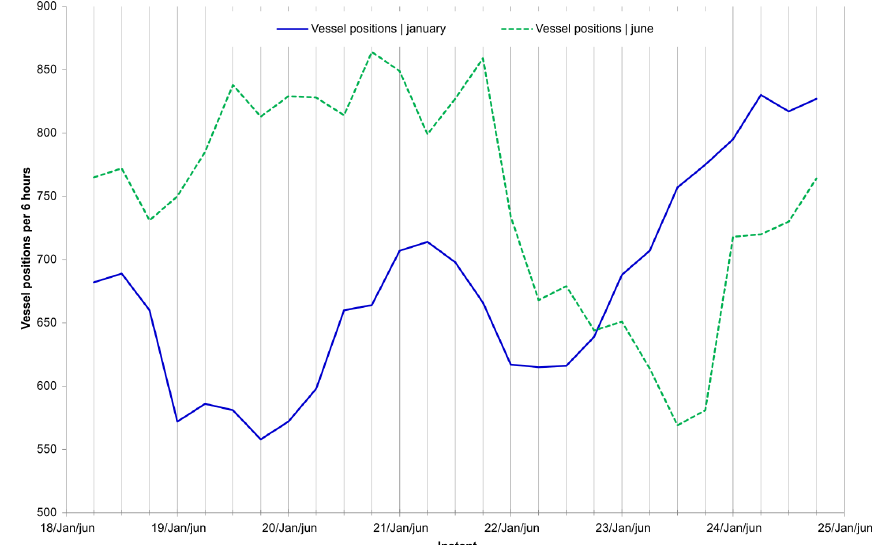
Figure 14. Recorded AIS vessel positions per 6h time intervals in the pilot area, obtained in two different weeks: 18–25 January and 18–25 June